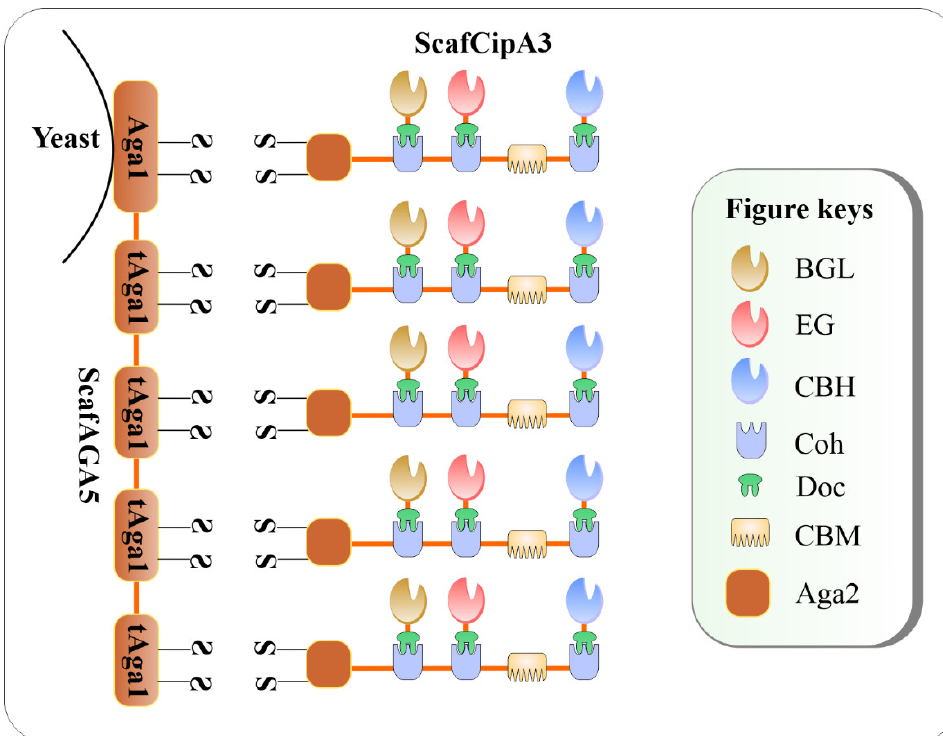
Figure 10. The attachment of trivalent Scaf on S. cerevisiae cell surface via covalent disulfide bonds of tAga1p–Aga2. This approach helps to improve surface display efficiency relative to the common CohII–DocII binding.